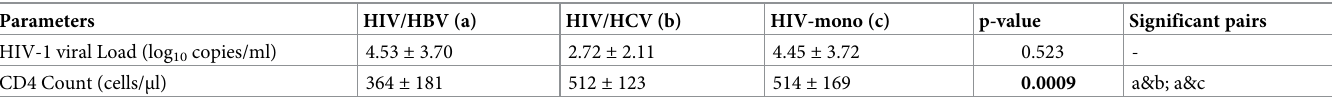
Table 3. Virological and cellular markers of HIV among HIV positive participants.